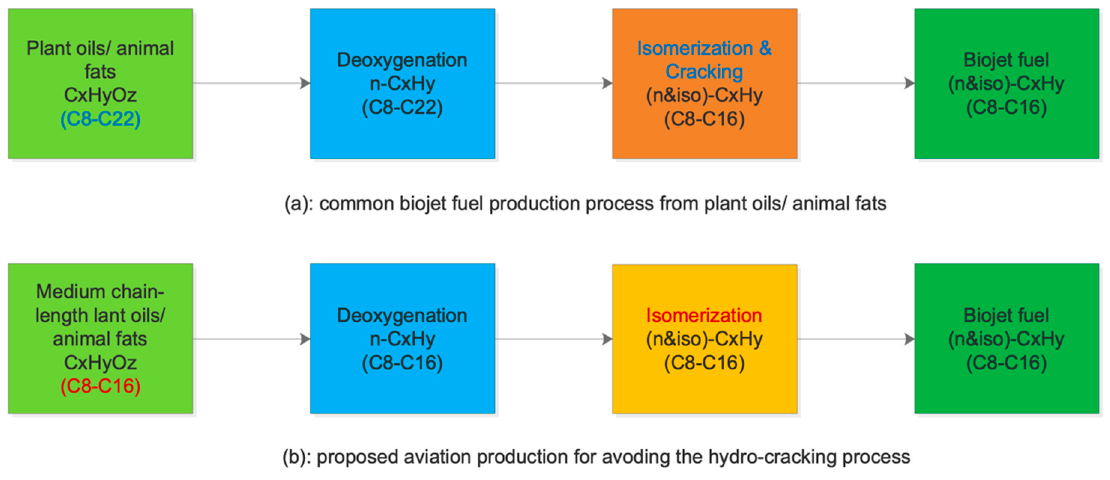
Figure 1. Comparison of ( a ) common biojet-fuel production processes based on plant oils and animal fats and ( b ) proposed aviation production for avoiding hydrocracking process.